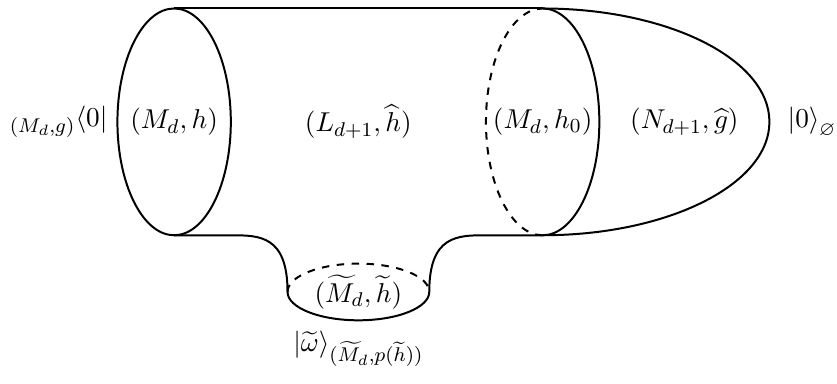
Figure 1 . The geometric con(cid:12)guration de(cid:12)ning P ( h ) in